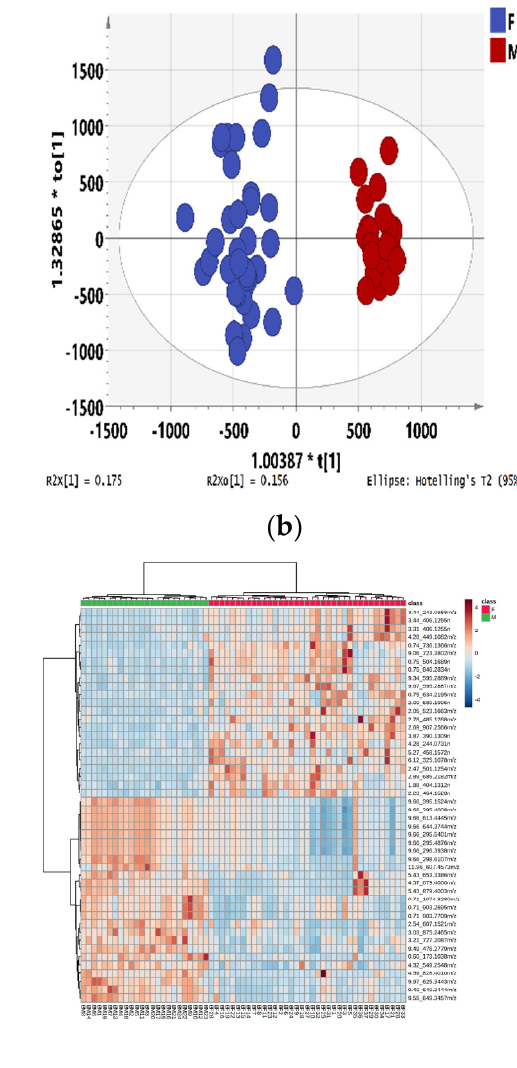
Table 2. Differential metabolites for male and female stem barks, filtered with VIP > 1, |p| ≥ 0.05 and |p(corr)| ≥ 0.5, ANOVA p value ≤ 0.05, and max fold change ≥ 1.5.